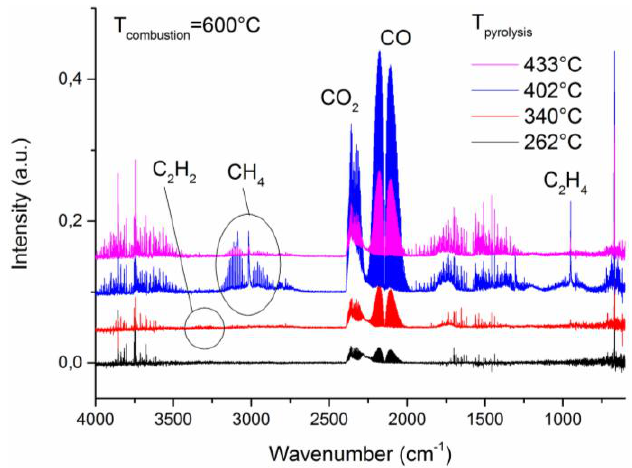
Figure 2. FTIR spectra of gases exhausted from MCC after pyrolysis of 15% EDA-DOPO at various pyrolysis temperatures and under combustion conditions at 600 °C.